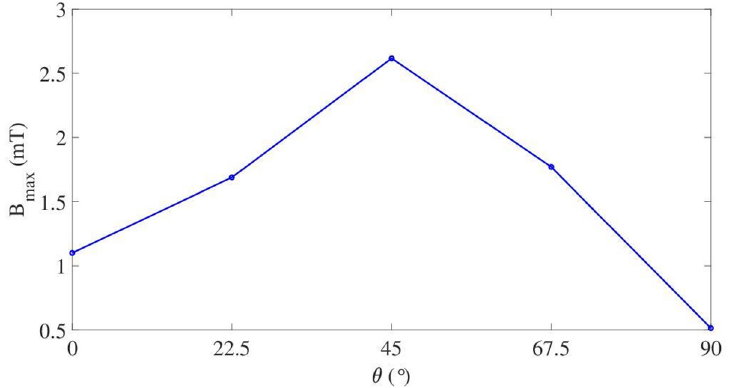
Figure 11. Maximum magnetic induction relative to angle θ for specimen 1 .